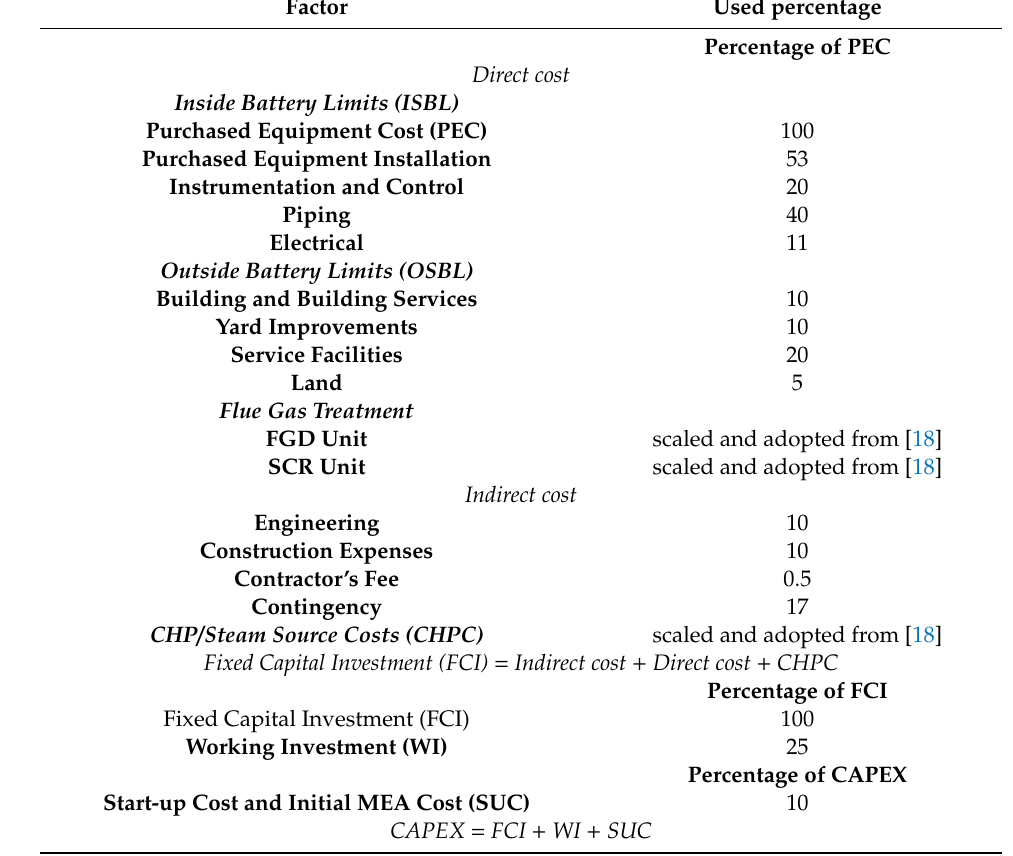
Table A3. CAPEX calculation and cost factors from the literature [40].